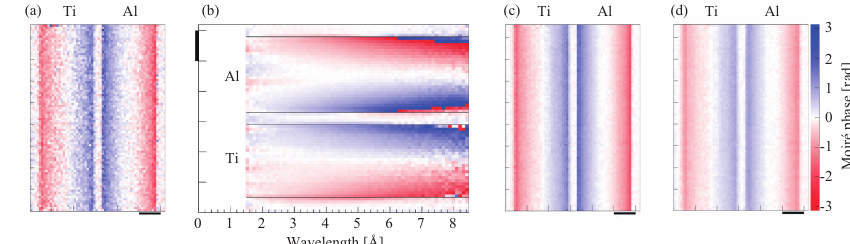
Figure 12. Results (differential phase images) obtained for rod samples of Ti and Al by a neutron Talbot–Lau interferometer with the time-of-flight (TOF) method: ( a ) Image obtained from the data of 5 Å only, ( b ) wavelength dependence of the differential phase, ( c ) image calculated assuming ϕ x ∝ λ 2 , and ( d ) image produced in the normal way with out resolving energy (wavelength). The color implies the moiré phase, which corresponds to z s ϕ x / d 2 . Scale bar: 2